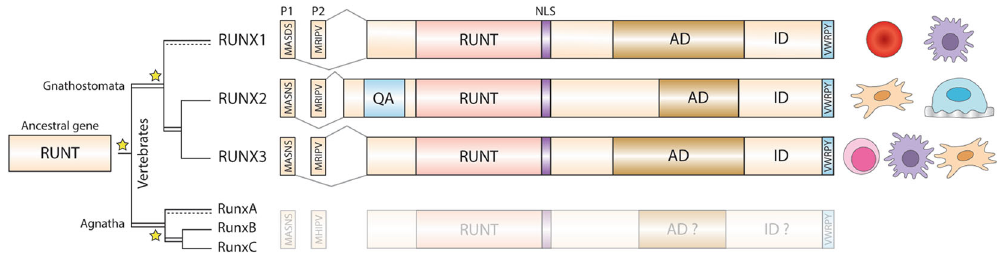
Fig. 1 Evolution and structure of the RUNX family of transcription factors. The ancestral metazoan RUNT gene locus underwent two independent rounds of duplication (stars, double lines) near the base of the vertebrate tree to derive the three modern RUNX paralogs in gnathostomes and cyclostomes. Each modern RUNX locus contains a conserved dual P1/P2 promoter, and overall structural homology sharing the RUNT DNA-binding domain, activation (AD) and inhibition (ID) domains, nuclear localization signal (NLS), and C-terminus VWRPY motif. Each member has diverged unique tissue speci fi city,